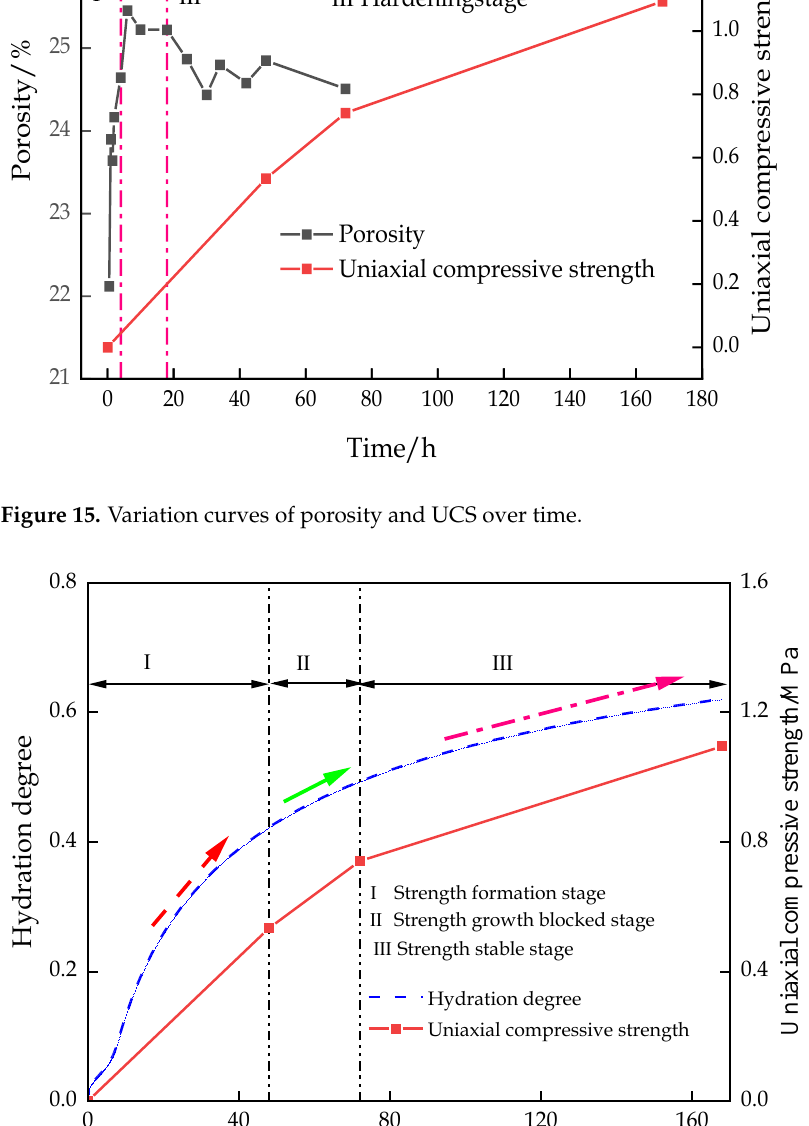
Figure 16. Variation curves of hydration degree and UCS over time.